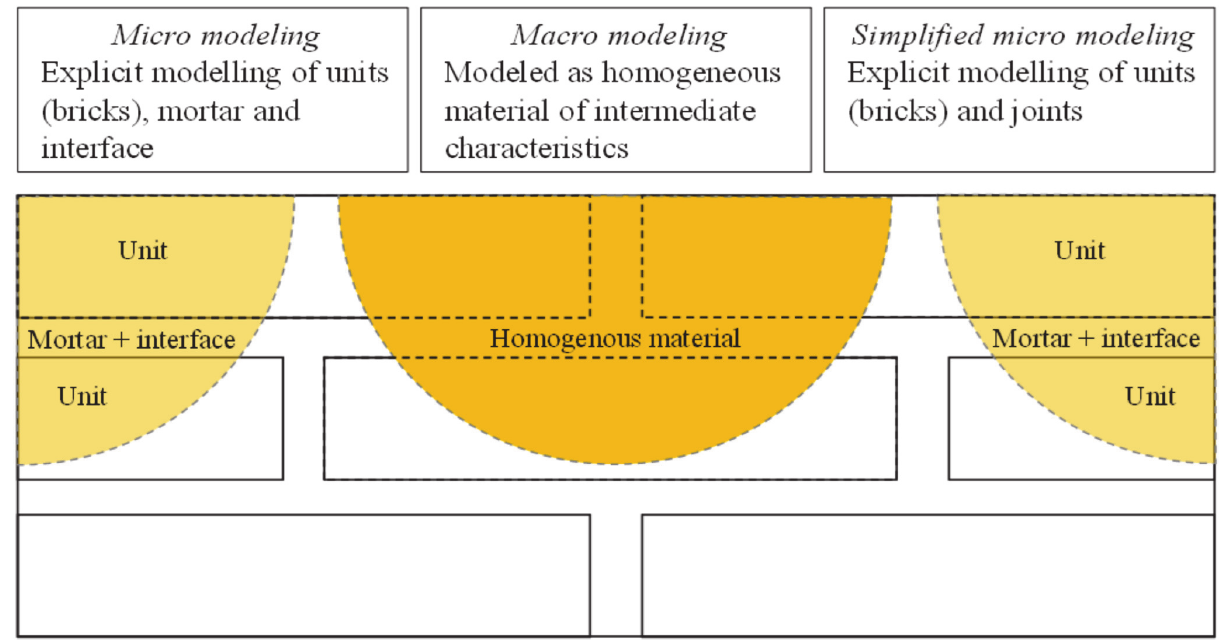
Figure 1: Modelling techniques for masonry